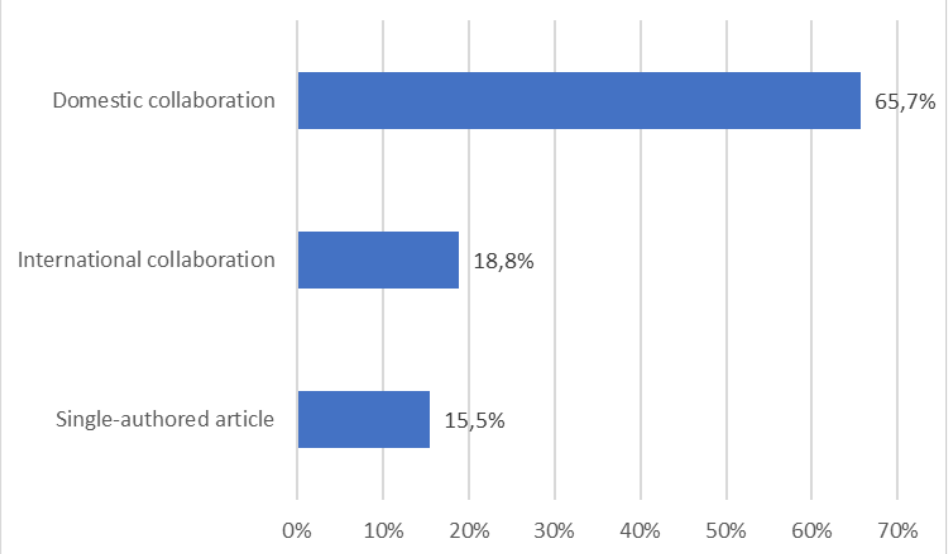
Figure 4. Type of authorship of the